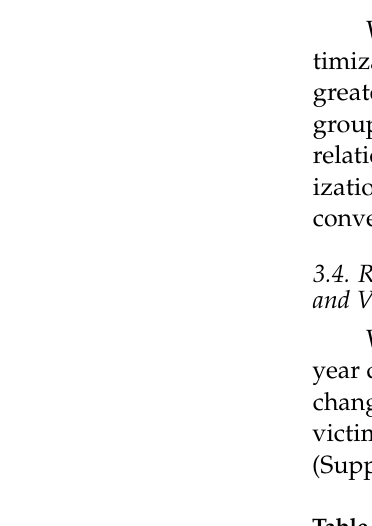
Table 3. Results of logistic regression analyses for changes in state-level policy scores (2017–2019) and their association with past year discrimination and victimization among an online national cohort of sexual and/or gender minority people ( N =